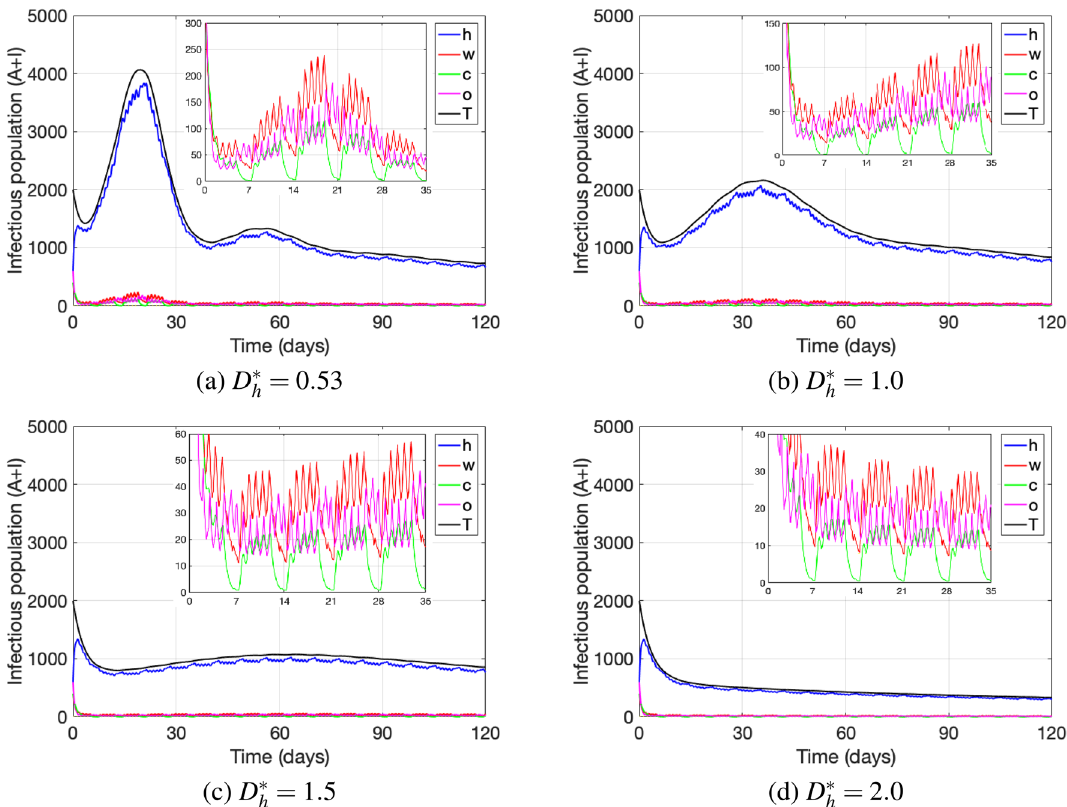
Figure 7. The sub-figures show the dynamics of active cases for different natural distances at home, under the measure where simultaneously going to work, school, and other locations is restricted. The parameter values used are as in Table